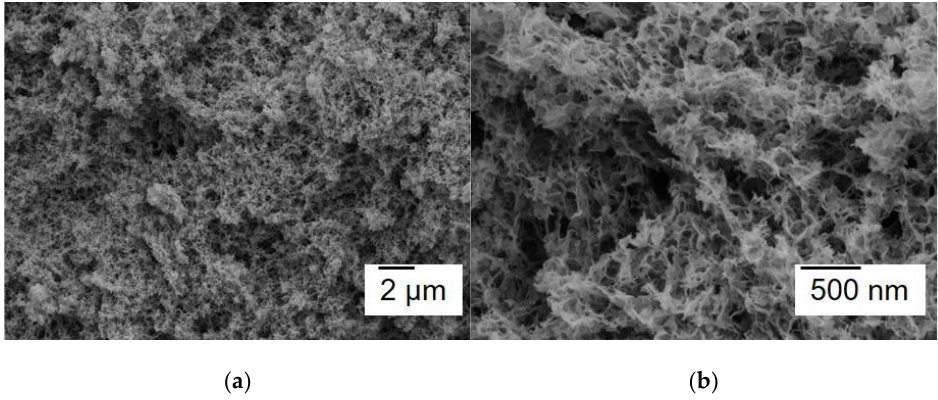
Figure 5. SEM images of the morphology of the prepared composite cellulose aerogel containing Ag NPs: under low ( a ) and high magnification ( b ).